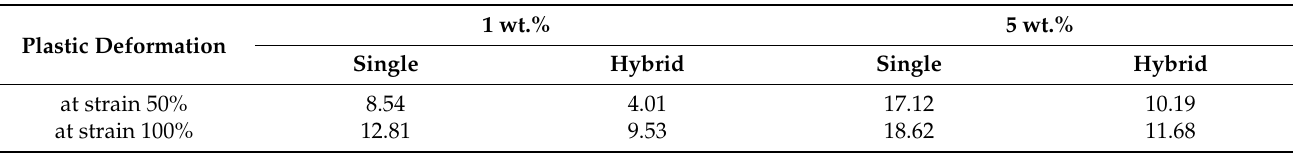
Table 2. Degree of plastic deformation of the MWNT/NR composite, based on each concentration and structural formation.